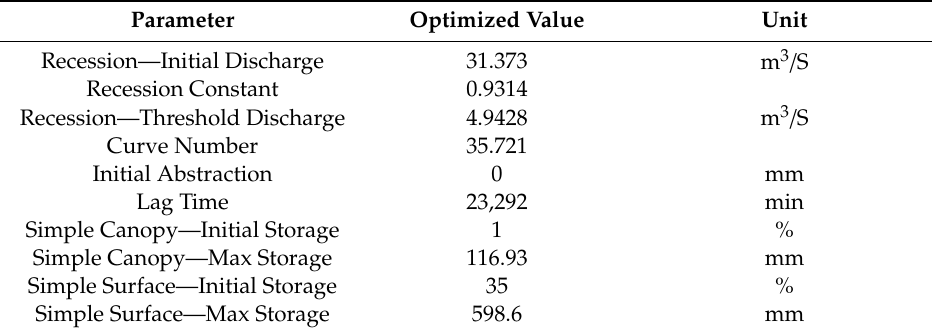
Table 8. Optimized model parameters.